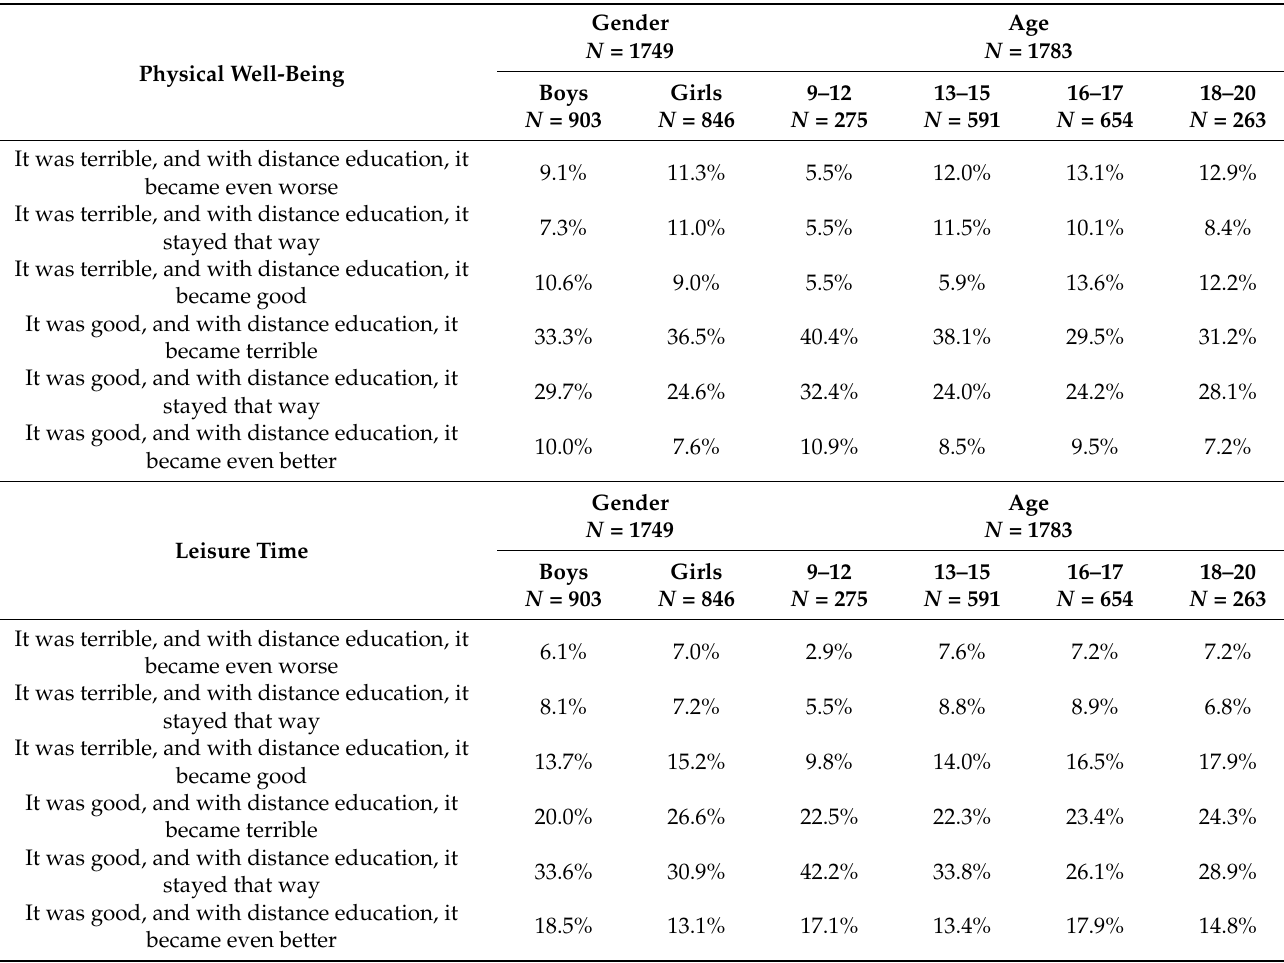
Table 1. Dependent results of the